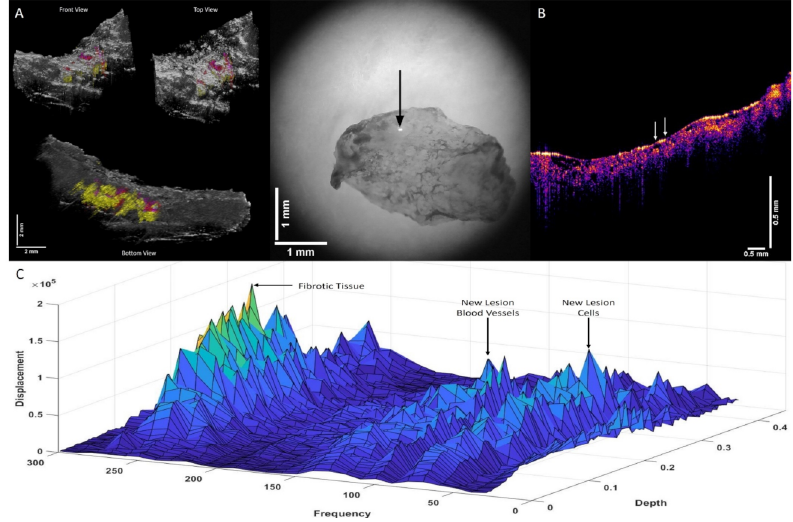
Figure 4. Three-dimensional color-coded OCT images ( A ) (left) of a nodular basal cell carcinoma (BCC), illustrating the location of new cells (80 Hz) and new lesion blood vessels (130 Hz) (red), and fibrotic tissue (260 Hz) (yellow). The camera image of the lesion is shown in the center, and the arrow denotes where the VOCT measurements were made. ( B ) shows an OCT image of the BCC cross-section shown in A. Note the lesion is seen as the small black dot seen below the left arrow. ( C ) shows a 3D plot of weighted displacement versus frequency and versus depth showing the location of skin cells (50 Hz), new cells (80 Hz), dermal collagen (100 Hz,), new blood vessels, (130 Hz) and fibrotic tissue (260 Hz) for a nodular